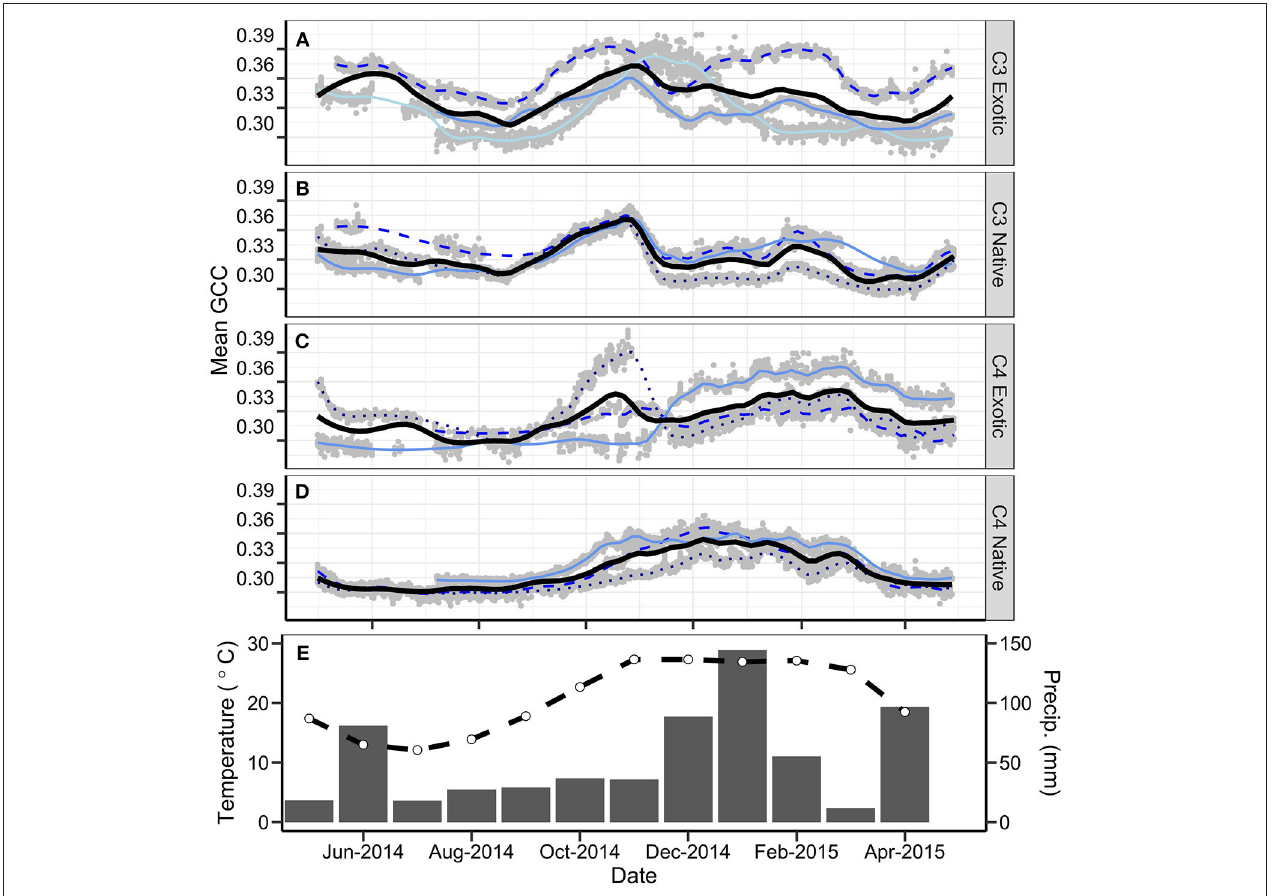
FIGURE 3 | Annual combined g CC phenology profiles for all sites, grouped by functional type, (A) C 3 Exotic, (B) C 3 Native, (C) C4 Exotic, (D) C4 Native. Gray dots represent hourly data points. Blue lines represent individual sites. The thick black line of each panel is a LOESS fitted curve (span = 0.1) for each functional type. Panel (E) represents the monthly mean maximum temperature ( ◦ C; dashed line; Tuggeranong Bureau of Meteorology station) and the monthly rainfall (mm; solid bars; Australian National Botanic Gardens Bureau of Meteorology station) for the study